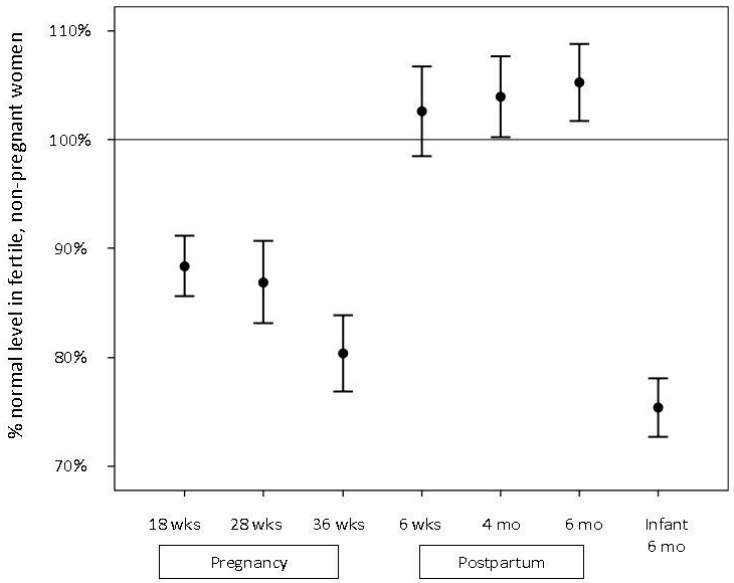
Figure 1. Selenium levels in pregnant and lactating women and their infants, expressed as the percentage of median selenium level in never-pregnant women (mean + 2 SD).